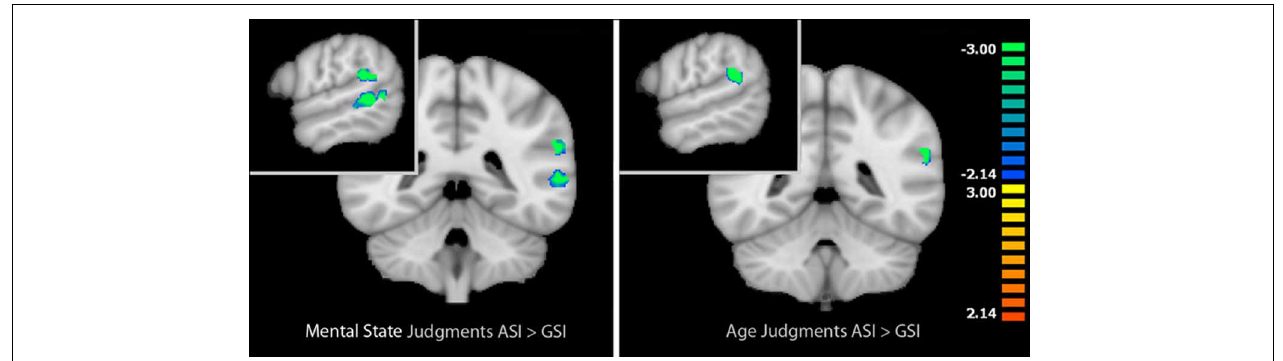
FIGURE 2 | Left: Regions that showed differential activation between mental state and age judgments in the baseline RMET-R that were modulated by stress induction type during mental state judgments. Right: Regions that showed differential activation between mental state and